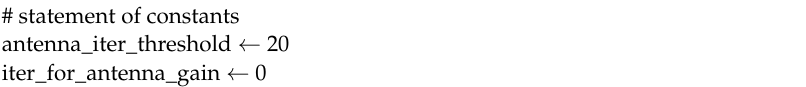
Algorithm 2 Antenna gain optimization